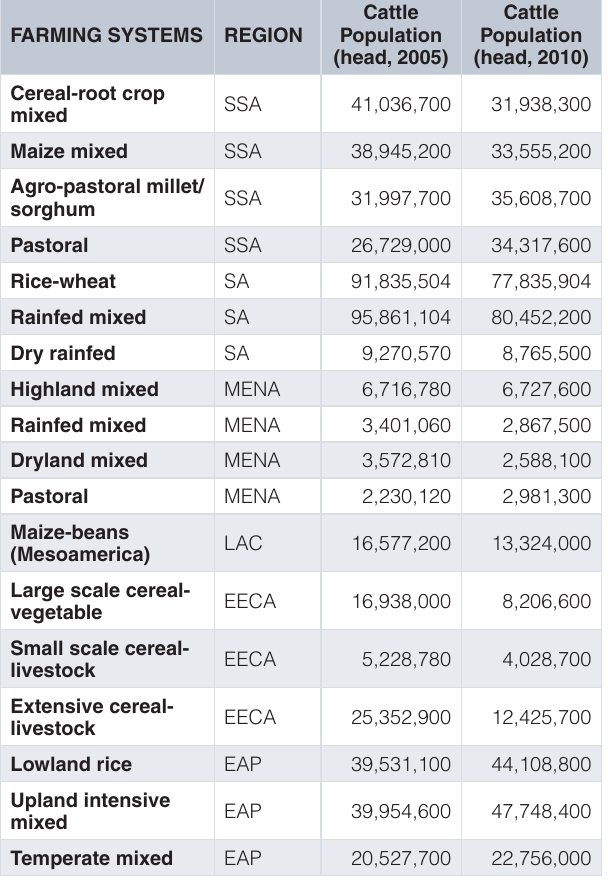
Table 4. Cattle population (head 2005 and 2010). FARMING SYSTEMS REGION